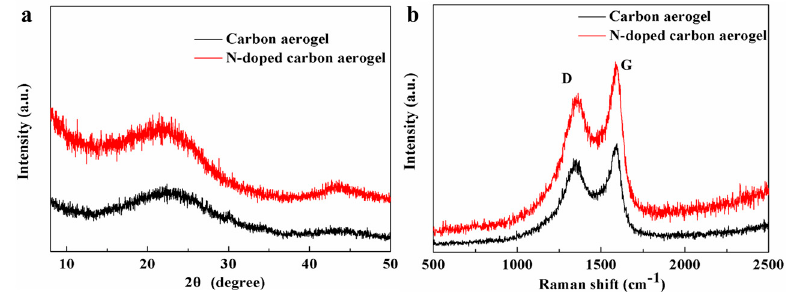
Figure 4. ( a ) XRD and ( b ) Raman analysis of carbon aerogel and N-doped carbon aerogel.